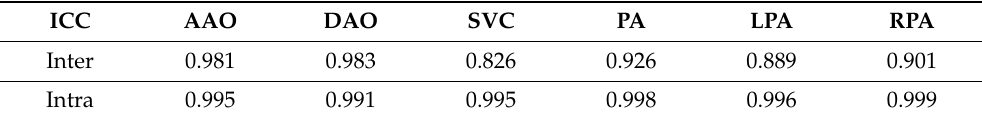
Table 3. Mean and standard deviation values for CO and SV.